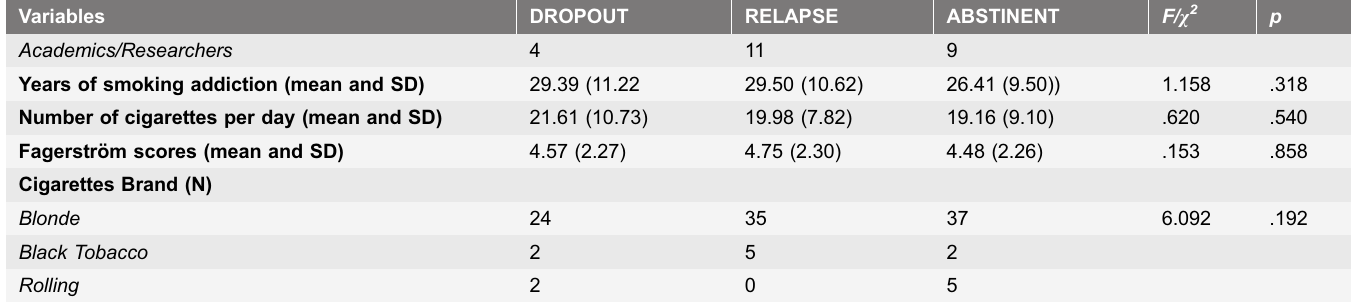
dependence, Wald statistic 5 5.28, p 5 0.02, were significantly and directly associated with Treatment Dropout. None of the temperament dimensions were significantly associated with relapse at 3 months. For the 6-month follow-up outcome, the model including TCI scores showed satisfactory fit, x 2 5 31.79, d.f. 5 8, p , 0.001, explaining 26% of variance, Nagelkerke pseudo-R 2 5 0.26. Inspection of parameter estimates showed that the dimensions of novelty seeking, Wald statistic 5 8.75, p 5 0.003, reward dependence, Wald statistic 5 3.93, p 5 0.047, and persistence, Wald statistic 5 6.45, p 5 0.01, were significantly and directly associated with Treatment Dropout. Moreover, the dimension of persistence was also significantly associated with Relapse at 6 months, Wald statistic 5 5.90, p 5 0.02. For the 12-month follow-up outcome, the model including TCI scores showed satisfactory fit, x 2 5 24.55, d.f. 5 8, p , 0.01, explaining 22% of variance, Nagelkerke pseudo-R 2 5 0.22. Inspection of parameter estimates showed that the dimensions of novelty seeking, Wald statistic 5 6.67, p 5 0.01, and reward dependence, Wald statistic 5 3.83, p 5 0.05, were significantly and directly associated with Treatment Dropout. None of the temperament dimensions were significantly associated with Relapse at 12 months (see Table 3). Multinomial regression models of impulsive measures predicting follow-up outcome (Drop-out and Relapse vs. Abstinence) For the 3-month follow-up outcome, the model including trait and cognitive impulsivity scores showed satisfactory fit, x 2 5 60.31, d.f. 5 12, p , 0.001, explaining 41% of variance, Nagelkerke pseudo-R 2 5 0.41. Inspection of parameter estimates showed that the BIS dimension of non-planning impulsivity was significantly and positively associated with both Treatment Dropout, Wald statistic 5 6.02, p 5 0.01, and Relapse, Wald statistic 5 5.34, p 5 0.02. For the 6-month follow-up outcome, the model including trait and cognitive impulsivity scores showed satisfactory fit, x 2 5 64.39, d.f. 5 12, p , 0.001, explaining 46% of variance, Nagelkerke pseudo-R 2 5 0.46. Inspection of parameter estimates showed that the BIS dimension of non-planning impulsivity was significantly and positively associated with Treatment Dropout, Wald statistic 5 4.69, p 5